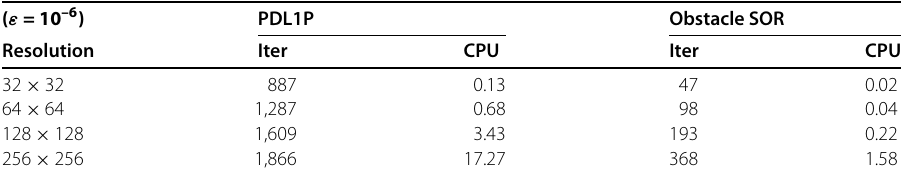
Table 3 The number of iterations and the CPU time for the elastic-plastic torsion problem (5.7)